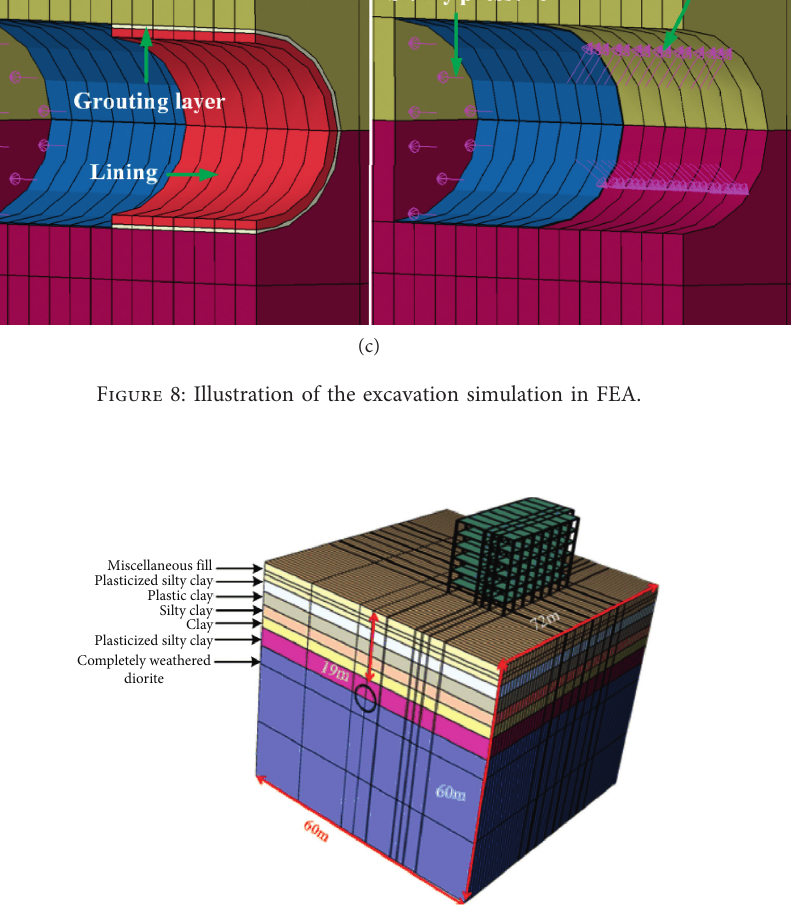
Figure 9: Three-dimensional numerical model of shield construction and its adjacent area.